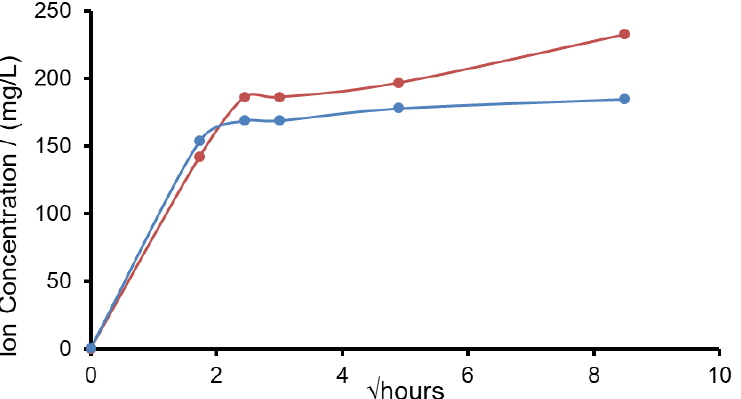
Figure 11. Release of sodium from Na-FBAG ( • ) and potassium ions from K-FBAG ( • ) in TB for up to 3 days.